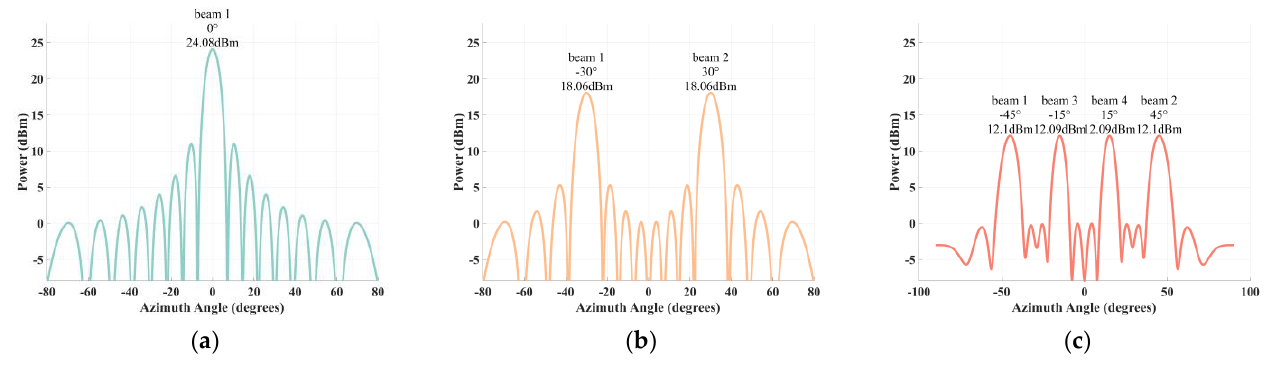
Figure 5. The multi − beam pattern in ideal condition. ( a ) single − beam mode; ( b ) dual − beam mode; ( c ) four − beam mode.